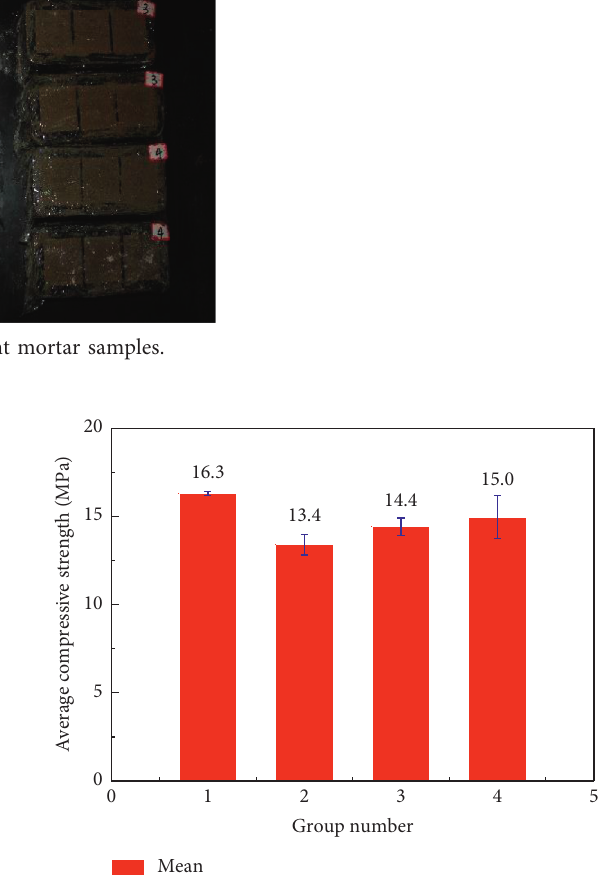
Figure 7: Statistics of 7-day compressive strength of each